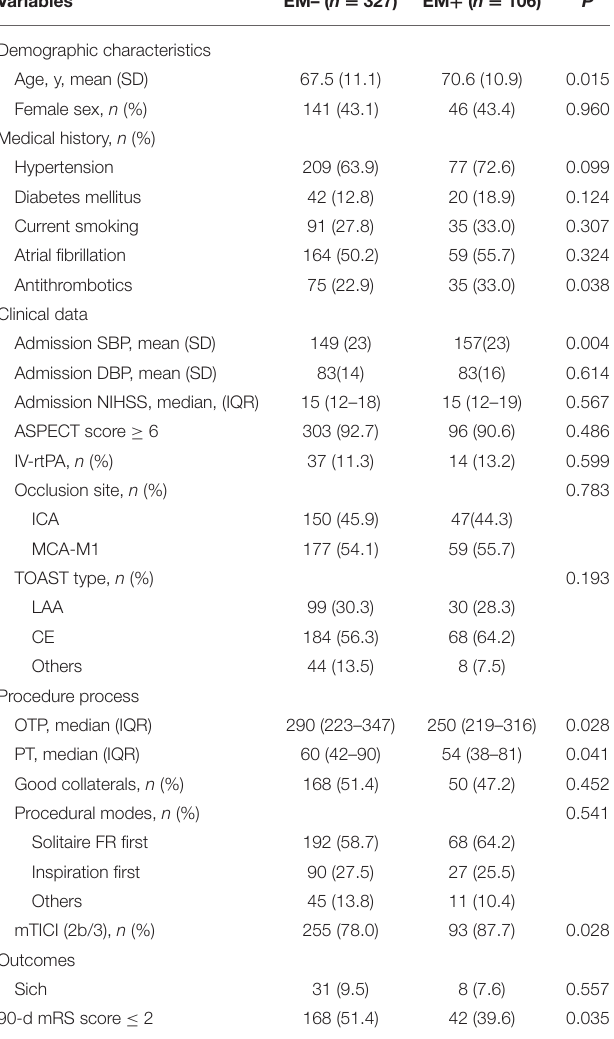
TABLE 1 | Baseline characteristics between patients with and without pre-existing encephalomalacia (EM). Variables